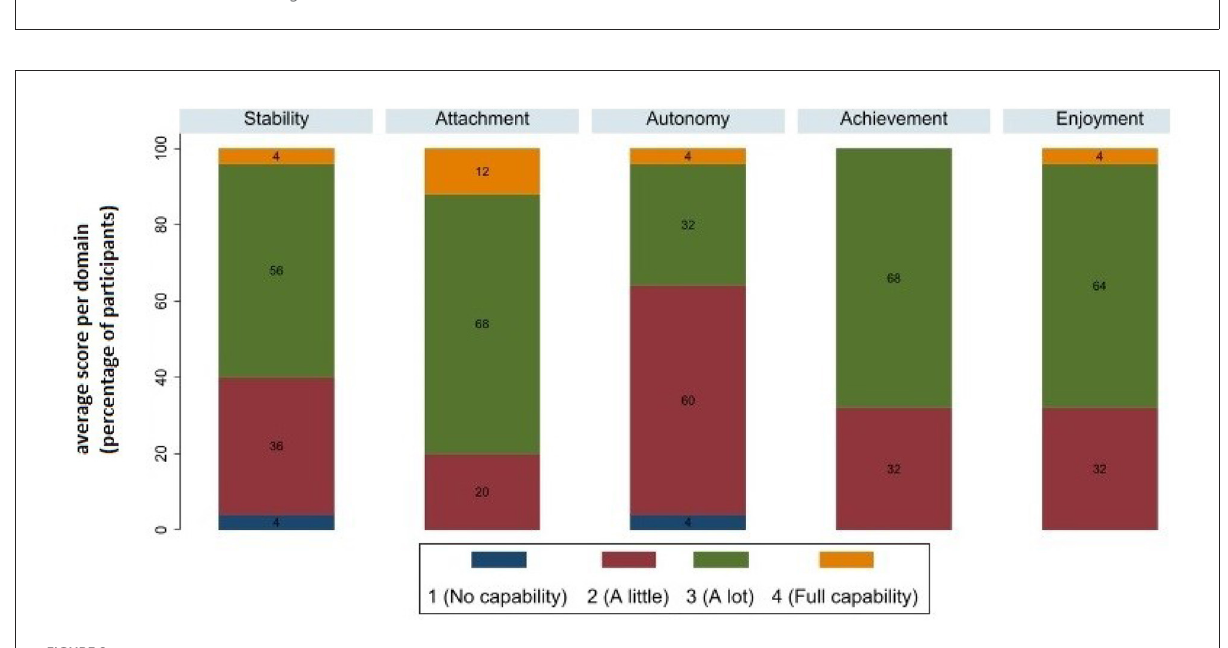
FIGURE1 EQ-5D-5L domain scores (a higher score reflects worse health).